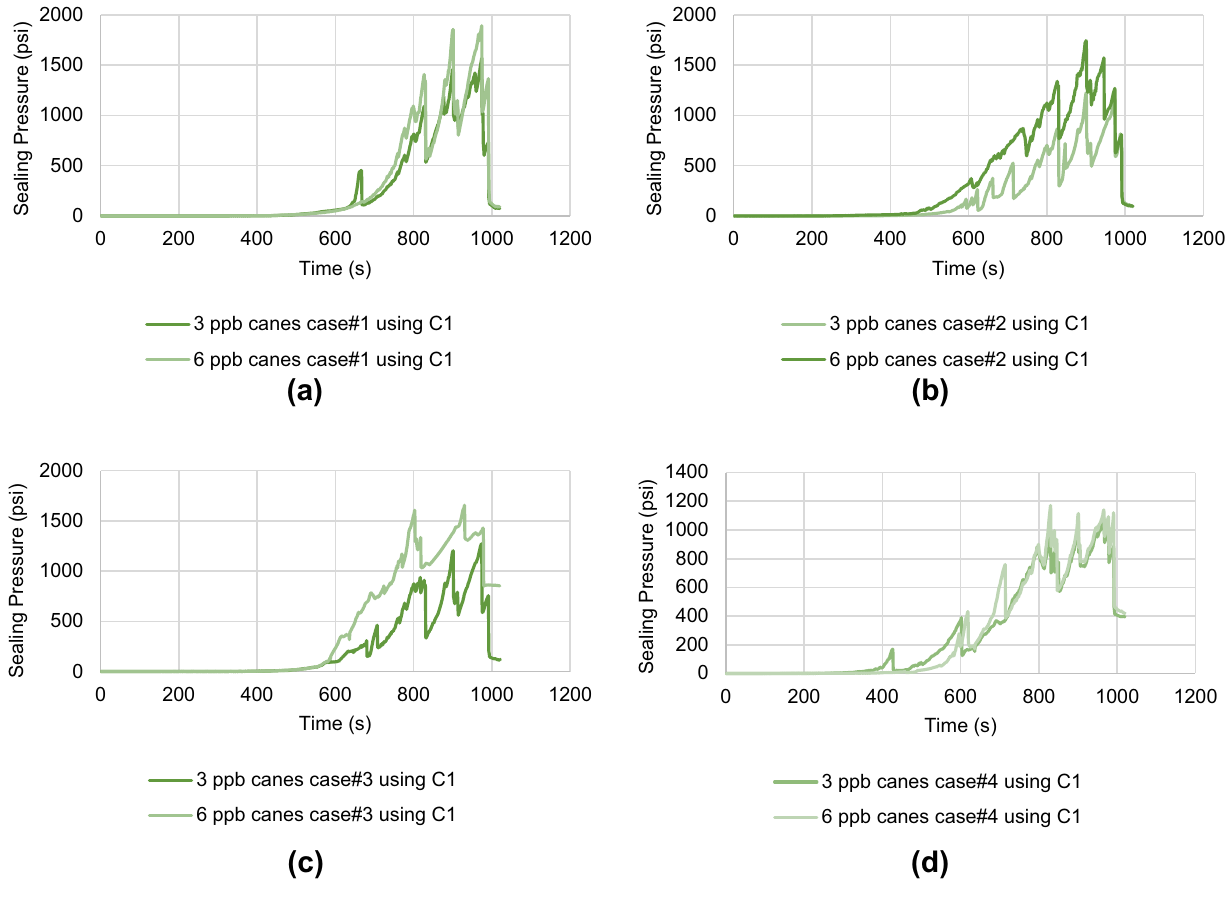
Fig. 17 HPA Pressure versus Time plot for Canes showing maximum sealing pressure at different concentrations, a case#1, b case#2, c case#3, d